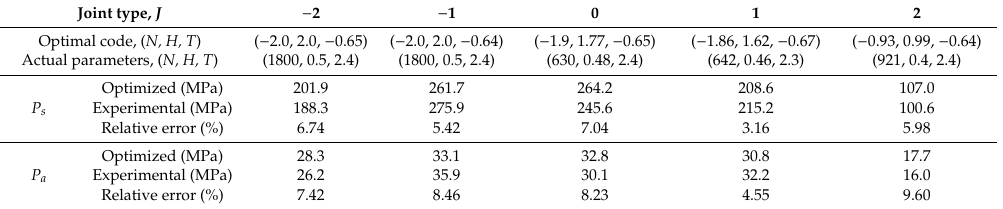
Figure 13. The optimization iterations andresult for the case of J = 0. Table 10. Multi-objective optimization results and their